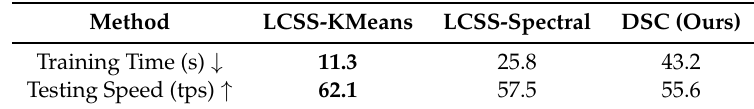
Table 6. The training time (in seconds, lower is better) and testing speed (trajectory per second, higher is better) of the three methods. The best values are highlighted using a bold typeface.